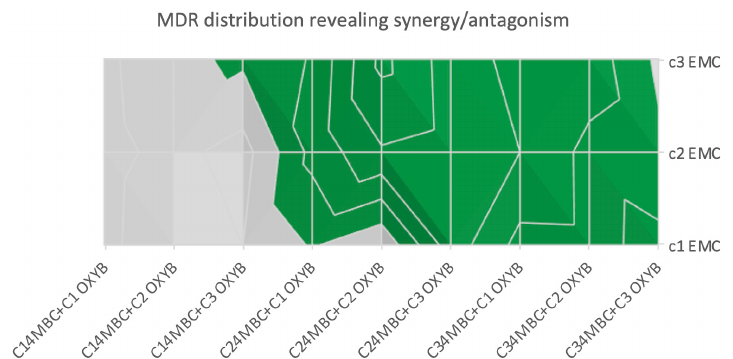
Figure 2. MDR values for IA modeling of the 4MBC, OXYB and EMC mixture of bioluminescent bacteria results ( n = 2). Red color indicates confirmed synergy, blue indicates antagonism, while yellow and green refer to under- and overestimation, respectively.